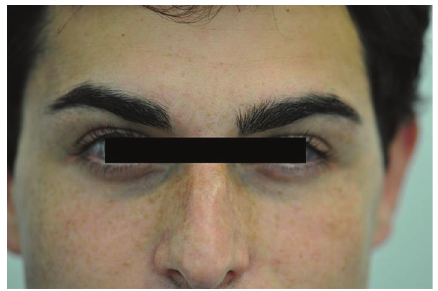
Figure 5: Nevus of Ota.